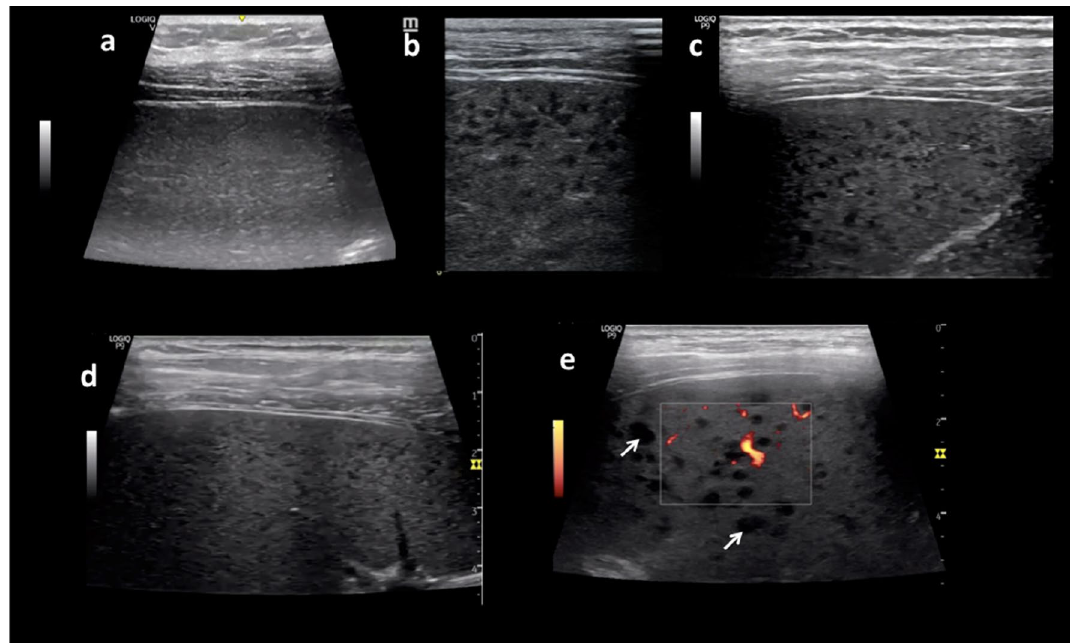
Fig. 2 Examples of spleen tissue a Normal homogenous spleen tissue; b Sponge pattern in a patient with disseminated Kaposi’s sarcoma, c with MAC infection (also in Additional file 3: Video clip S1a) d with underlying pulmonary PCP infection. e Micro-abscesses in the spleen of patient with disseminated TB for